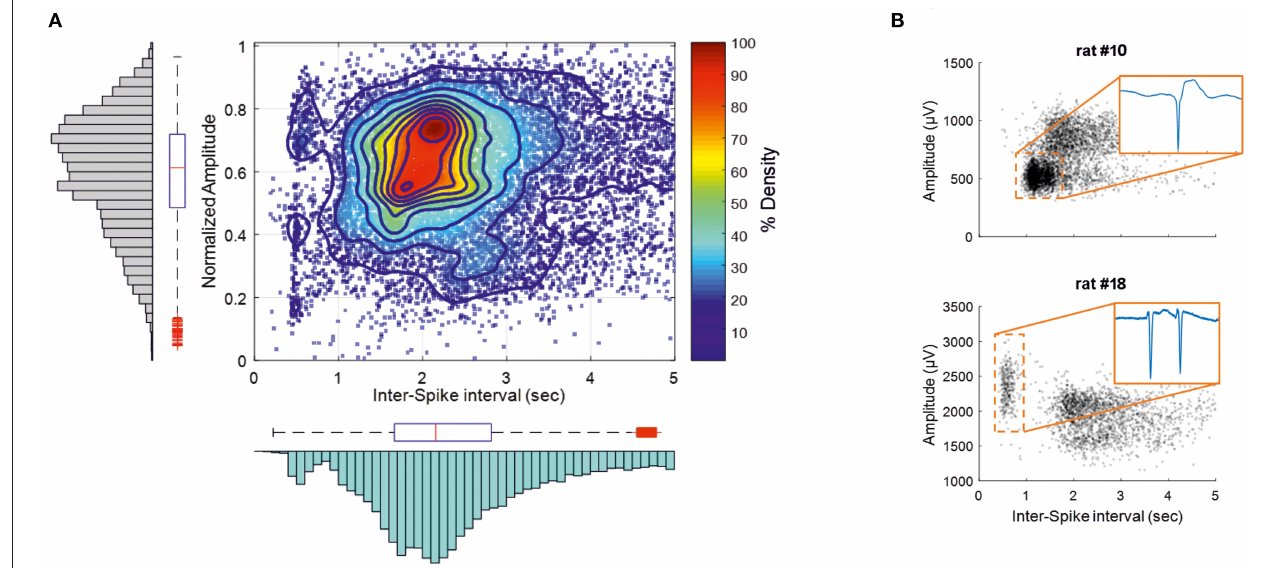
FIGURE 3 | IISs are plotted depending on the time interval between each IIS [Interspike interval (ISI)], related to the normalized amplitude measured at the maximum amplitude of the peak. (A) The color plot shows the density (%) of 13,300 IISs at determined times and amplitudes in 19 rats. The histogram and boxplot statistics are placed next to the axis from which the data were extracted. Red “ + ” corresponds to outliers. (B) Representations of two rats with different IIS firing rates and voltages.